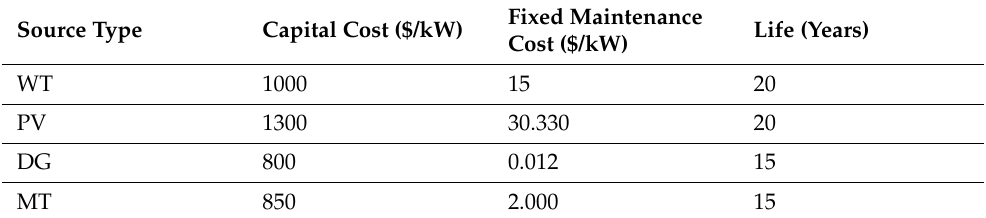
Table 8. Various costs and lifetime of sources involved in installing the MG.